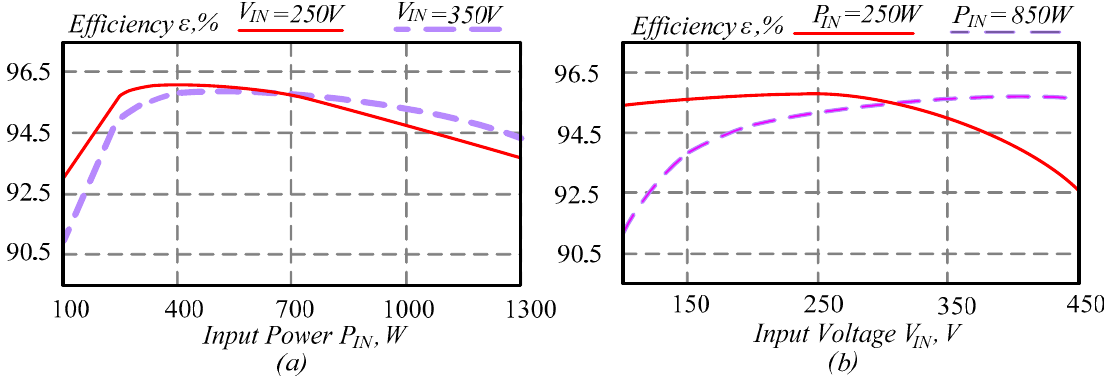
Figure 14. Efficiency versus input power in the bidirectional mode with constant input voltage ( a ), efficiency versus input voltage with constant input power ( b ).